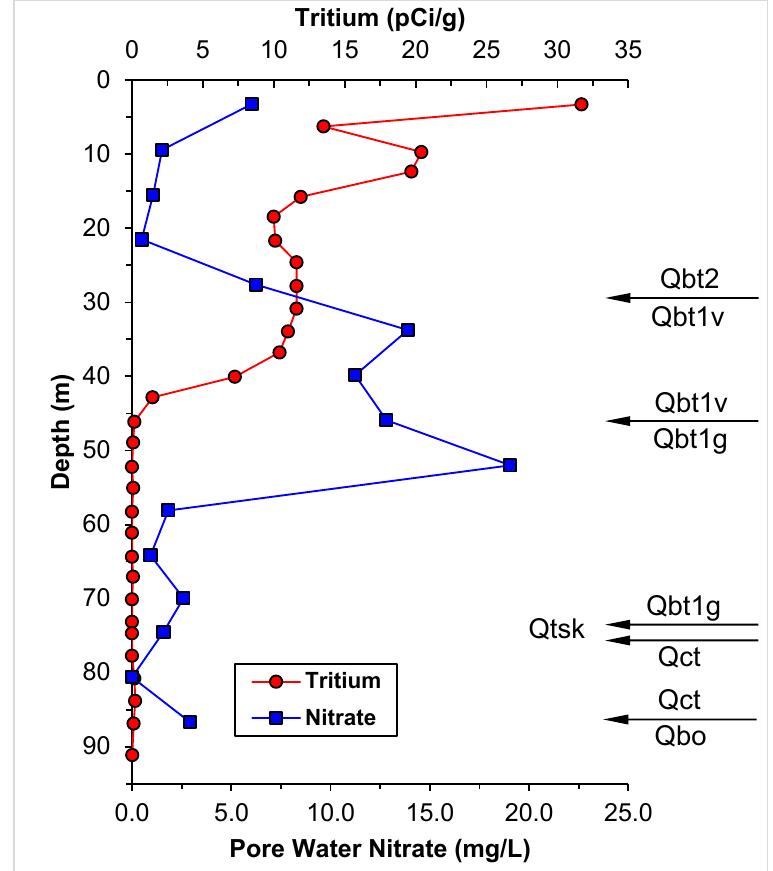
Figure 12. Comparison of nitrate and tritium profiles in Borehole 7.